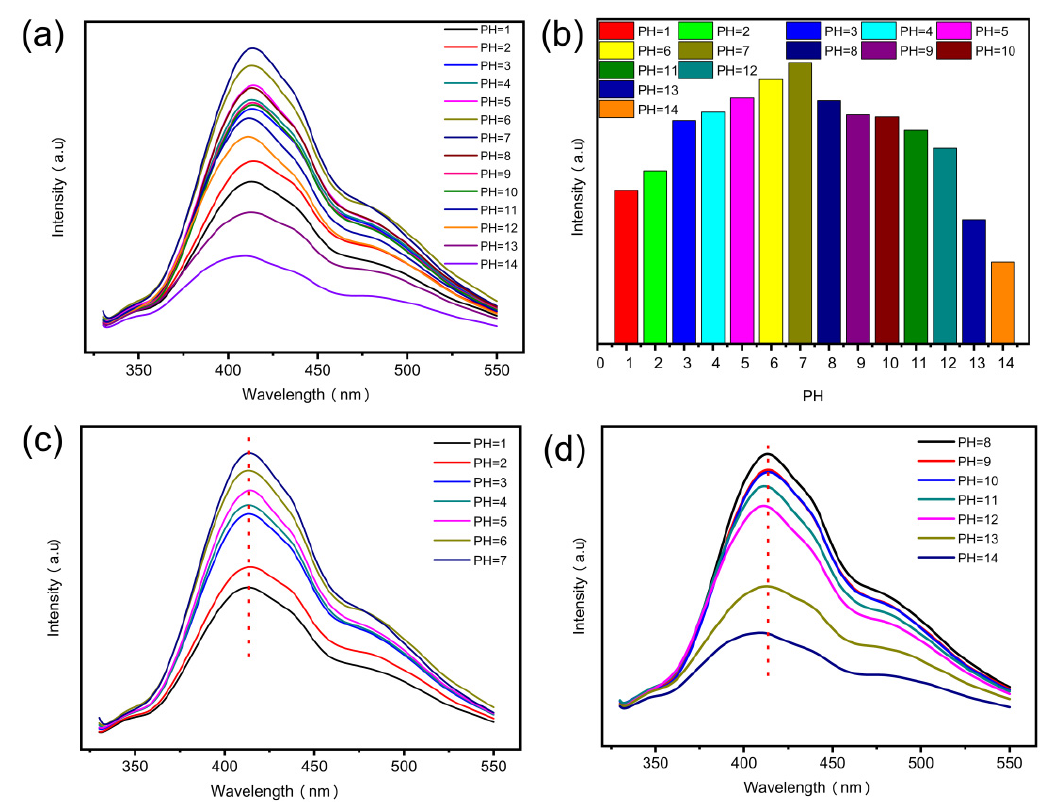
Figure 4. The impact of pH on N-CQDs fluorescence intensity.( a ) The fluorescence spectrum of PH from 1 to 14 N-CQDs, ( b ) The fluorescence spectrum of PH from 1 to 14 N-CQDs, ( c ) The fluorescence spectrum of PH from 1 to 7 N-CQDs, ( d ) The fluorescence spectrum of PH from 8 to 14